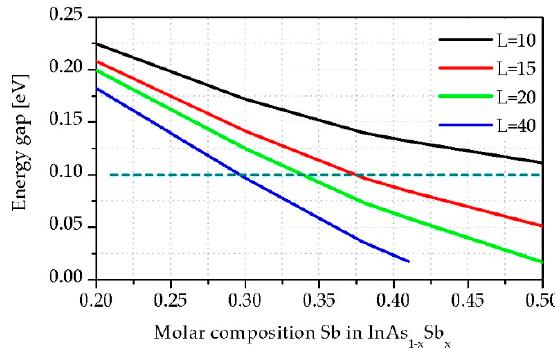
Figure 2. Theoretically simulated E g for the InAs/InAsSb strain balanced superlattice (SL) structures versus x Sb at T = 230 K.